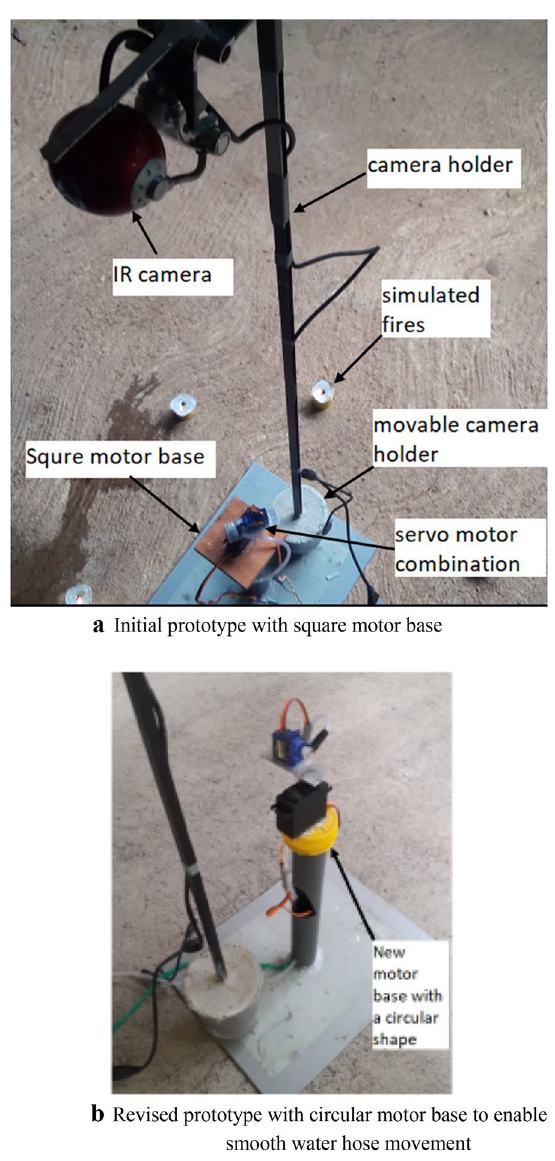
Fig. 3 Details of the prototype built, with camera on top of the pole and water dispenser at the lower level